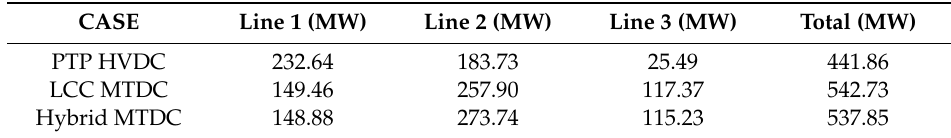
Table 1. Parallel alternating current (AC) transmission line power flow results of the third terminal 200 MW output.